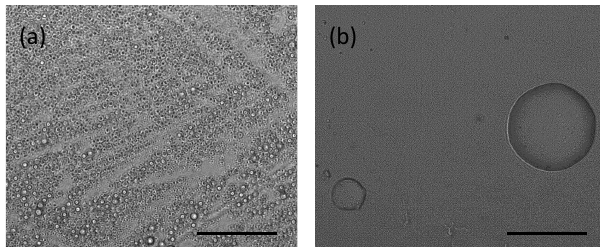
Figure 1. Images of isoprene-derived SOM particles on a hydropho- bic substrate. (a) SOM particles after collection from the OFR and (b) SOM particles after being exposed to a cycle droplet growth, coagulation, and evaporation (see text for further details). The sam- ples shown here were produced in the OFR with a concentration of 500–1000µgm − 3 (isoprene sample 3 in Table 1). Particles in (a) and (b) were exposed to 0 and 84% RH, respectively, when the im- ages were recorded. The size of the scale bar is